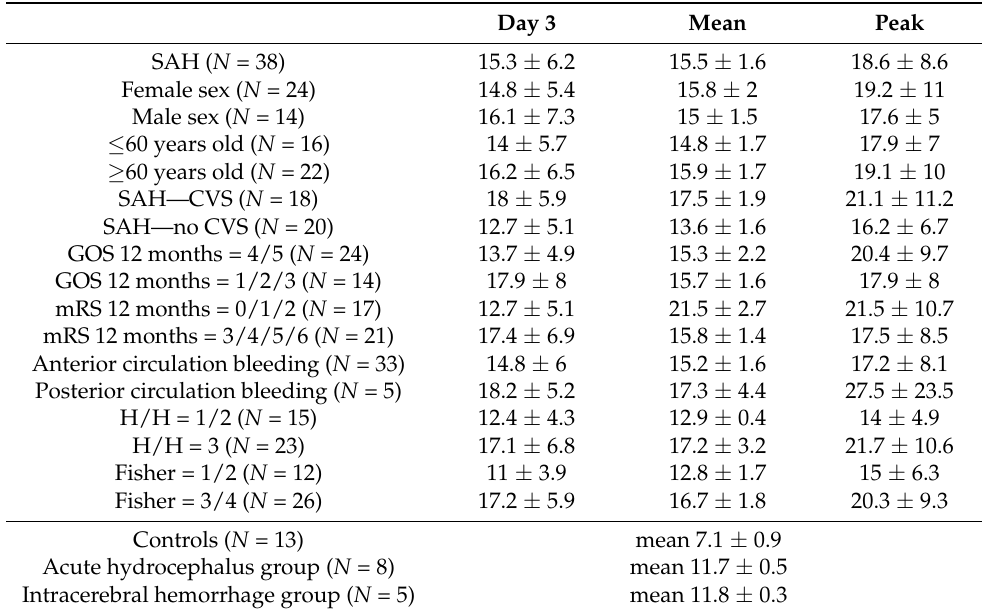
Table 3. Levels of urine F2-isoprostanes (pg/mg creatinine) in specific